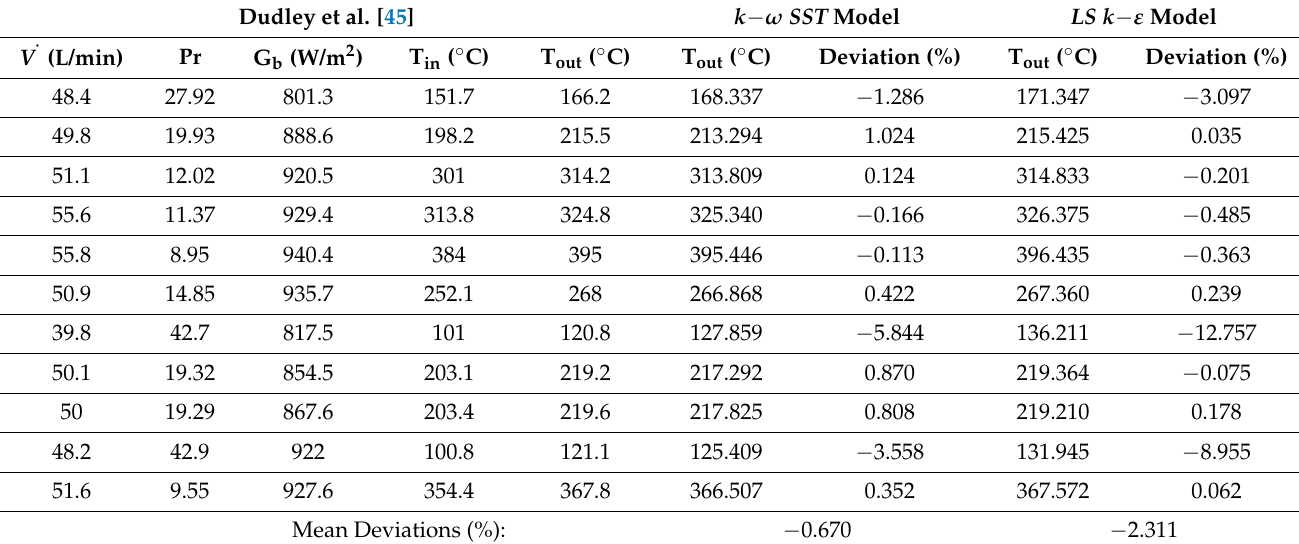
Table 5. Comparisons of the output temperature of the working fluid.